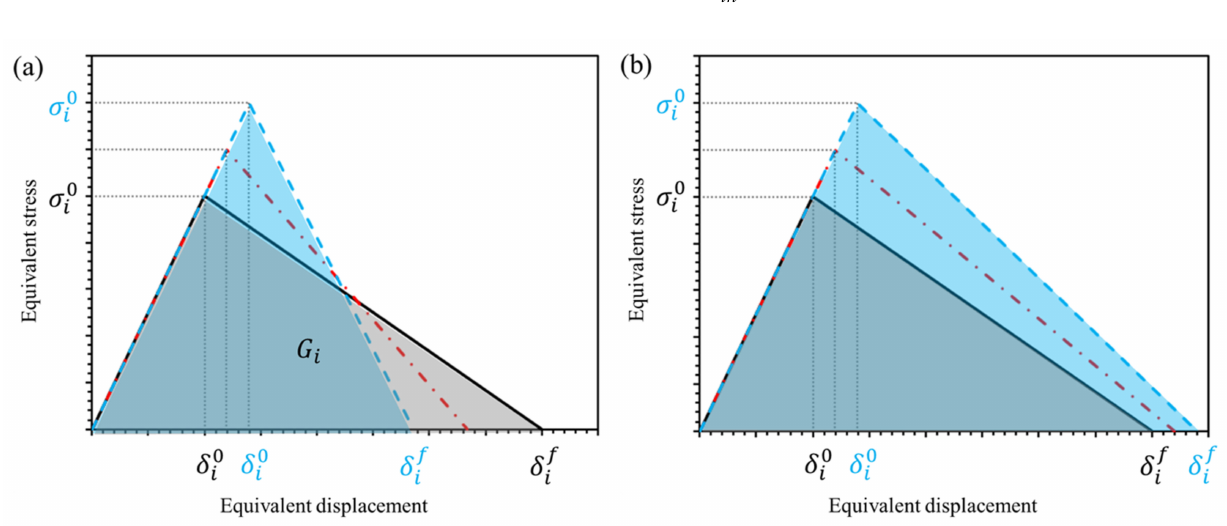
Figure 4. Schematic of bi-linear cohesive behaviour assuming: ( a ) constant fracture energy, ( b ) con- stant failure